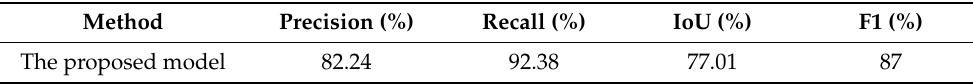
Table 2. Accuracy of the ISA mapping of the proposed